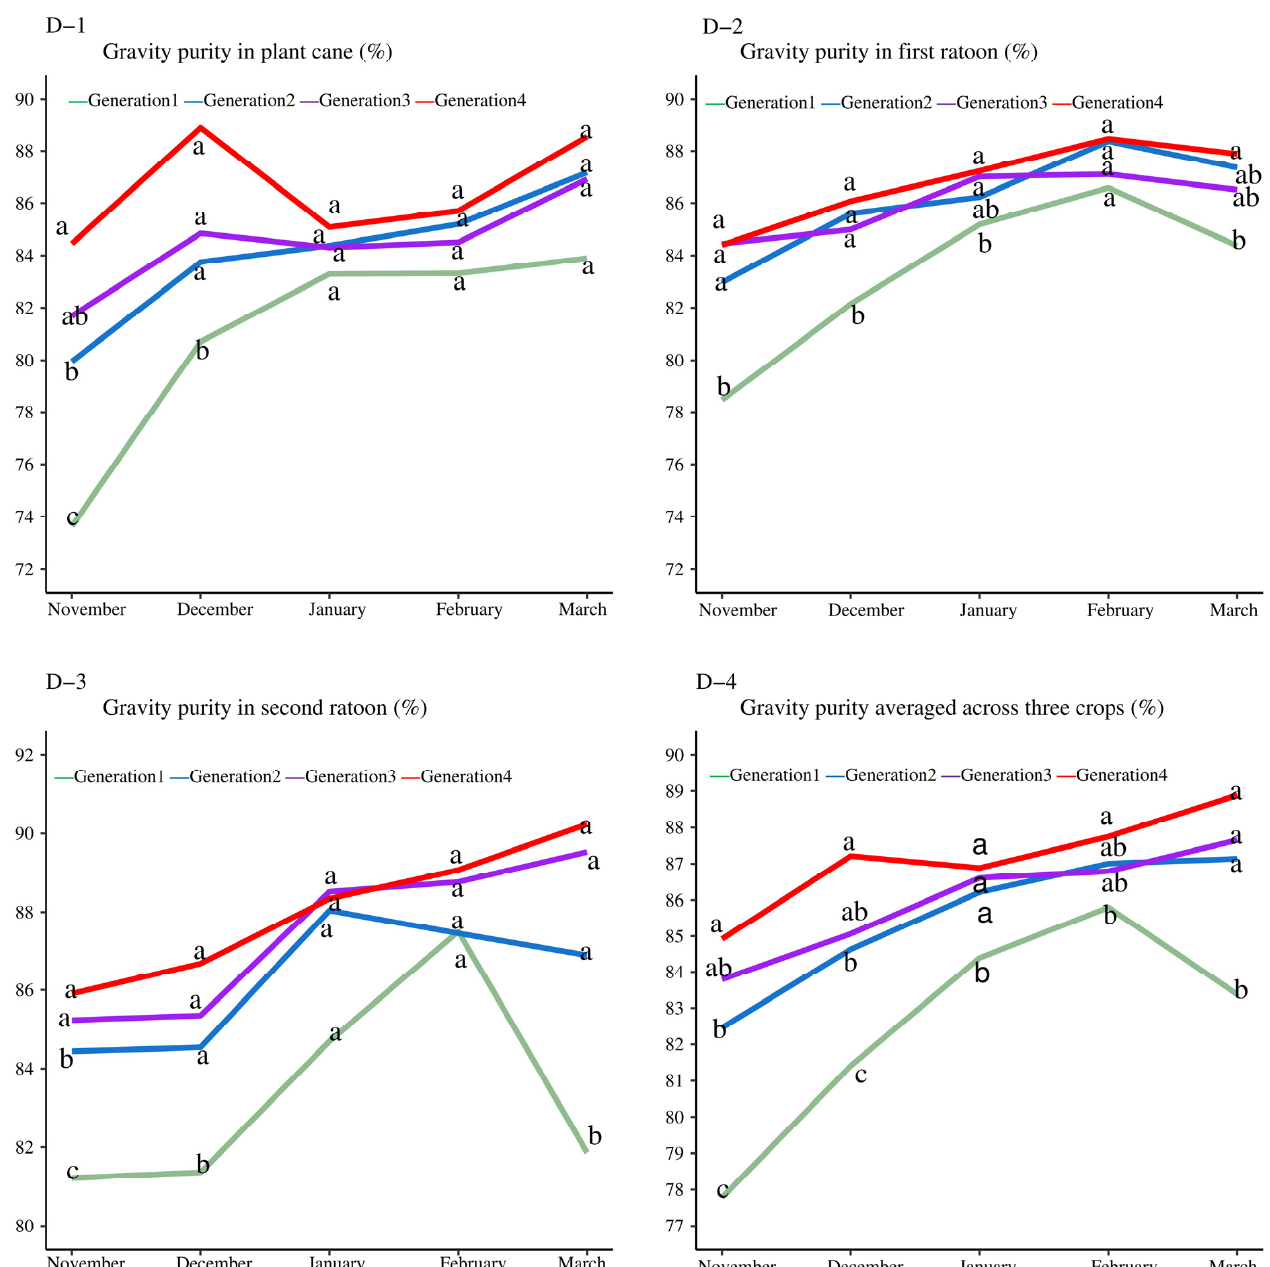
Figure 4. Analysis of the improvements in purity in four generations of sugarcane varieties in China. Monthly differences (November to March) of the four generations for the planted cane ( D-1 ), the first ratoon ( D-2 ), the second ratoon ( D-3 ), and the average content across all three crops ( D-4 ). a, b, c, p < 0.05, determined by the LSD test; the LSD test was across generations within a month.